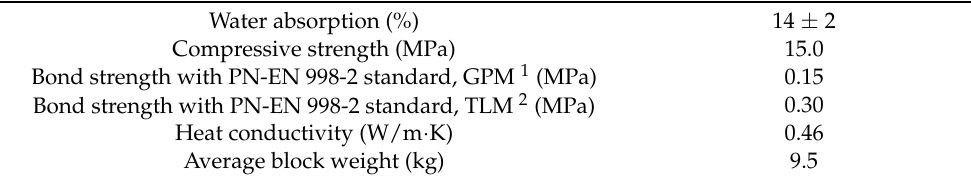
Table 3. Chosen properties of silicate blocks.